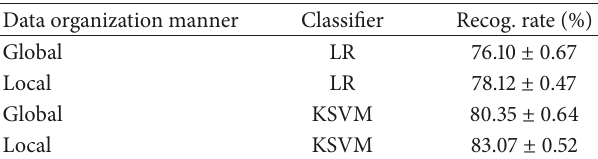
Table 1: Performance of the proposed method with different feature descriptors and classifiers.